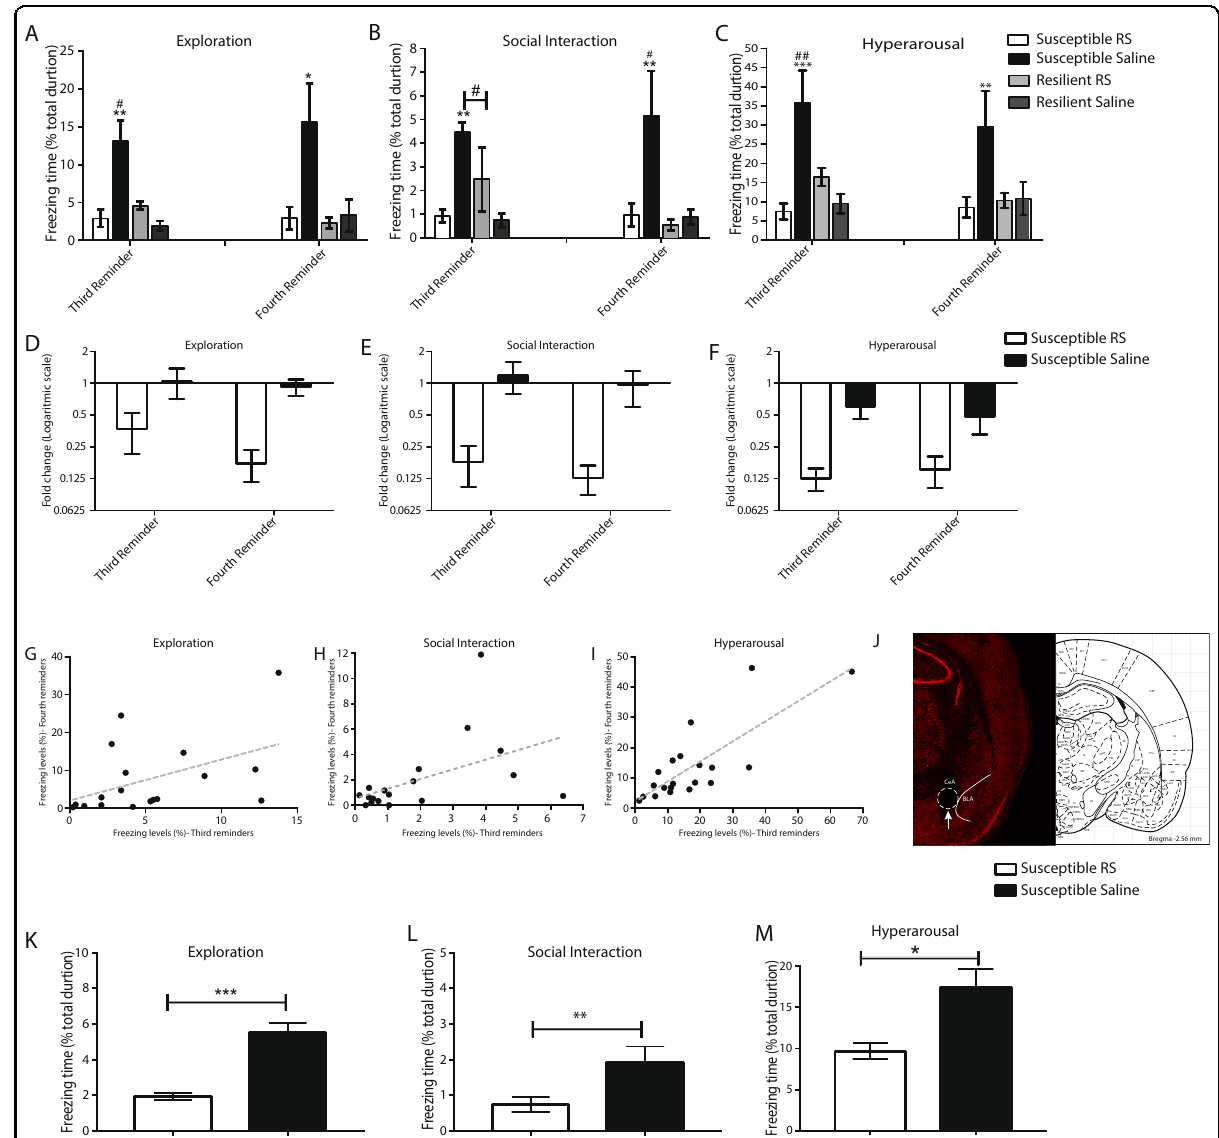
Fig. 3 Effect of RS-102221 antagonist treatment on PTSD-like behaviors. Susceptible and resilient animals received one injection of RS-102221 or control vehicle 15min before the third trauma reminder. Freezing behavior was assessed following the third reminder and fourth reminder in ( A ) exploration, ( B ) social interaction, and ( C ) hyperarousal tests. Bars represent freezing levels after the third and the fourth reminders showing a signi fi cant attenuation in freezing behavior of susceptible-RS-treated animals vs. susceptible- control-treated and all of the resilient groups (exploration: third reminder: ** p <0.01 for susceptible-control-treated vs. susceptible-RS-treated and resilient-control-treated animals, * p <0.05 susceptible-control-treated vs. resilient-RS- treated animals and * p <0.05 for susceptible-RA-treated vs. resilient-SAM and resilient- RA- treated groups. Fourth reminder: * p <0.05 for susceptible-RA- treated vs. all other experimental animals; social interaction: third reminder: ** p <0.001 for susceptible-control-treated vs. susceptible-RS and resilient-RS groups and # p <0.05 for susceptible-control-treated vs. resilient-RS treated group. Fourth reminder: ** p <0.01 for susceptible-control-treated vs. all resilient groups and # p <0.05 for susceptible-RA-treated vs. susceptible-control-treated animals; hyperarousal: third reminder: *** p <0.001 for susceptible-control- treated vs. susceptible-RS-treated and resilient-control-treated groups, ## p <0.01 susceptible-control-treated vs. resilient-RS-treated animals. Fourth reminder: ** p <0.01 for susceptible-control-treated vs. all other experimental animals. Data presented as mean ± SEM; n = 4-5 per group. ( D – F ) Fold change of freezing behavior in the susceptible-treated-groups in the third and fourth reminders compared to the freezing levels in the second reminder in ( D ) exploration, ( E ) social interaction, and ( F ) hyperarousal behavioral test. ( G – I ) Pearson ’ s product-moment correlation between the third and the fourth reminders in the following tests: ( G ) exploration ( H ) social interaction and ( I ) hyperarousal (r>0.45;* p <0.05). ( J ) Left: Image showing PI staining within the CeA. The overlay of the amygdala sub-nuclei demonstrates that the cannula placement is speci fi c to the CeA. The arrow points to the tip of the injection needle. Right: Corresponding section from rat stereotaxic atlas (Paxinos and Watson). ( K – M ) Susceptible animals received one systemic injection of RS- 102221 or control vehicle 30min before the third trauma reminder. Freezing behavior was assessed following the third reminder in ( K ) exploration (*** p < 0.001) ( L ) social interaction (** p <0.01) ( M ) hyperarousal (* p <0.05) tests comparing susceptible group treated with RS-102221 to susceptible group treated with vehicle control. Data presented as mean + SEM; n = 4-5 per